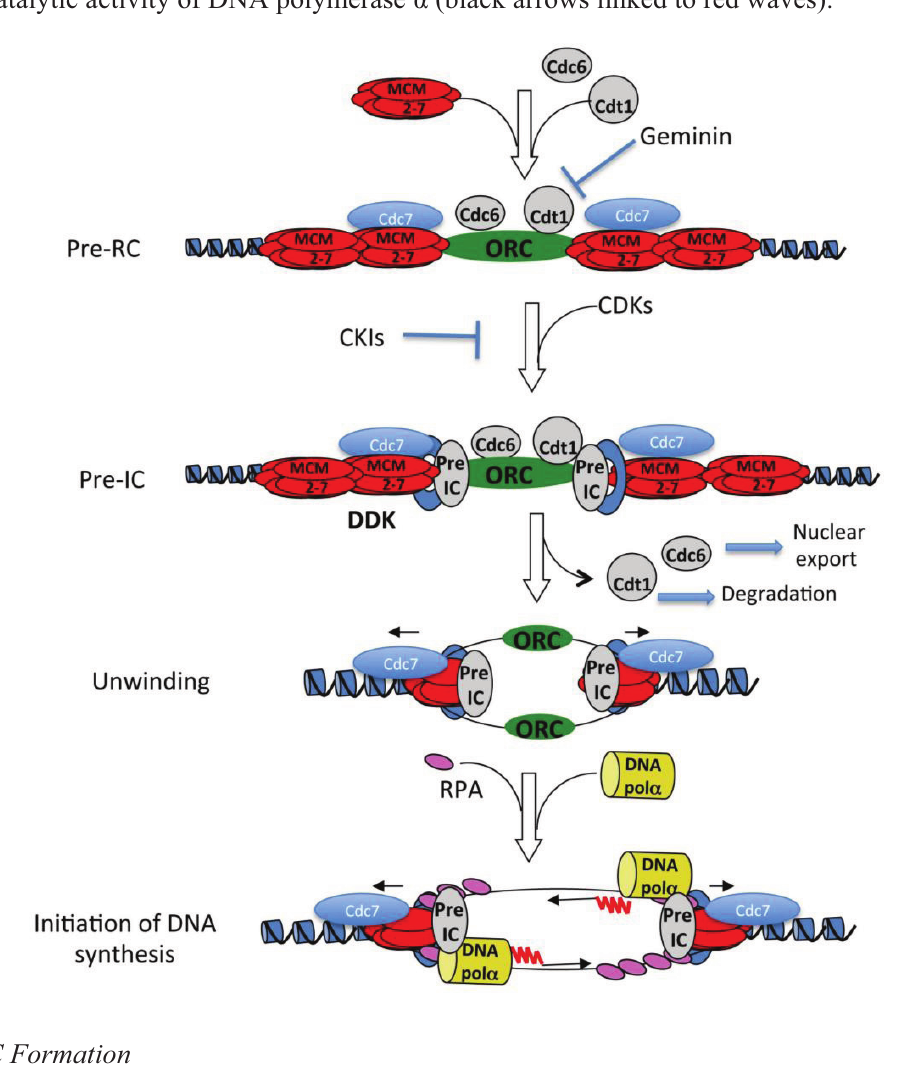
Figure 1. Schematic model of initiation of DNA synthesis. For sake of clarity, a number of proteins that make the pre-initiation complex (pre-IC) have been grouped in one complex. These include Cdc45, the GINS complex, MCM10, TopBP1, SLD2 and SLD3. A